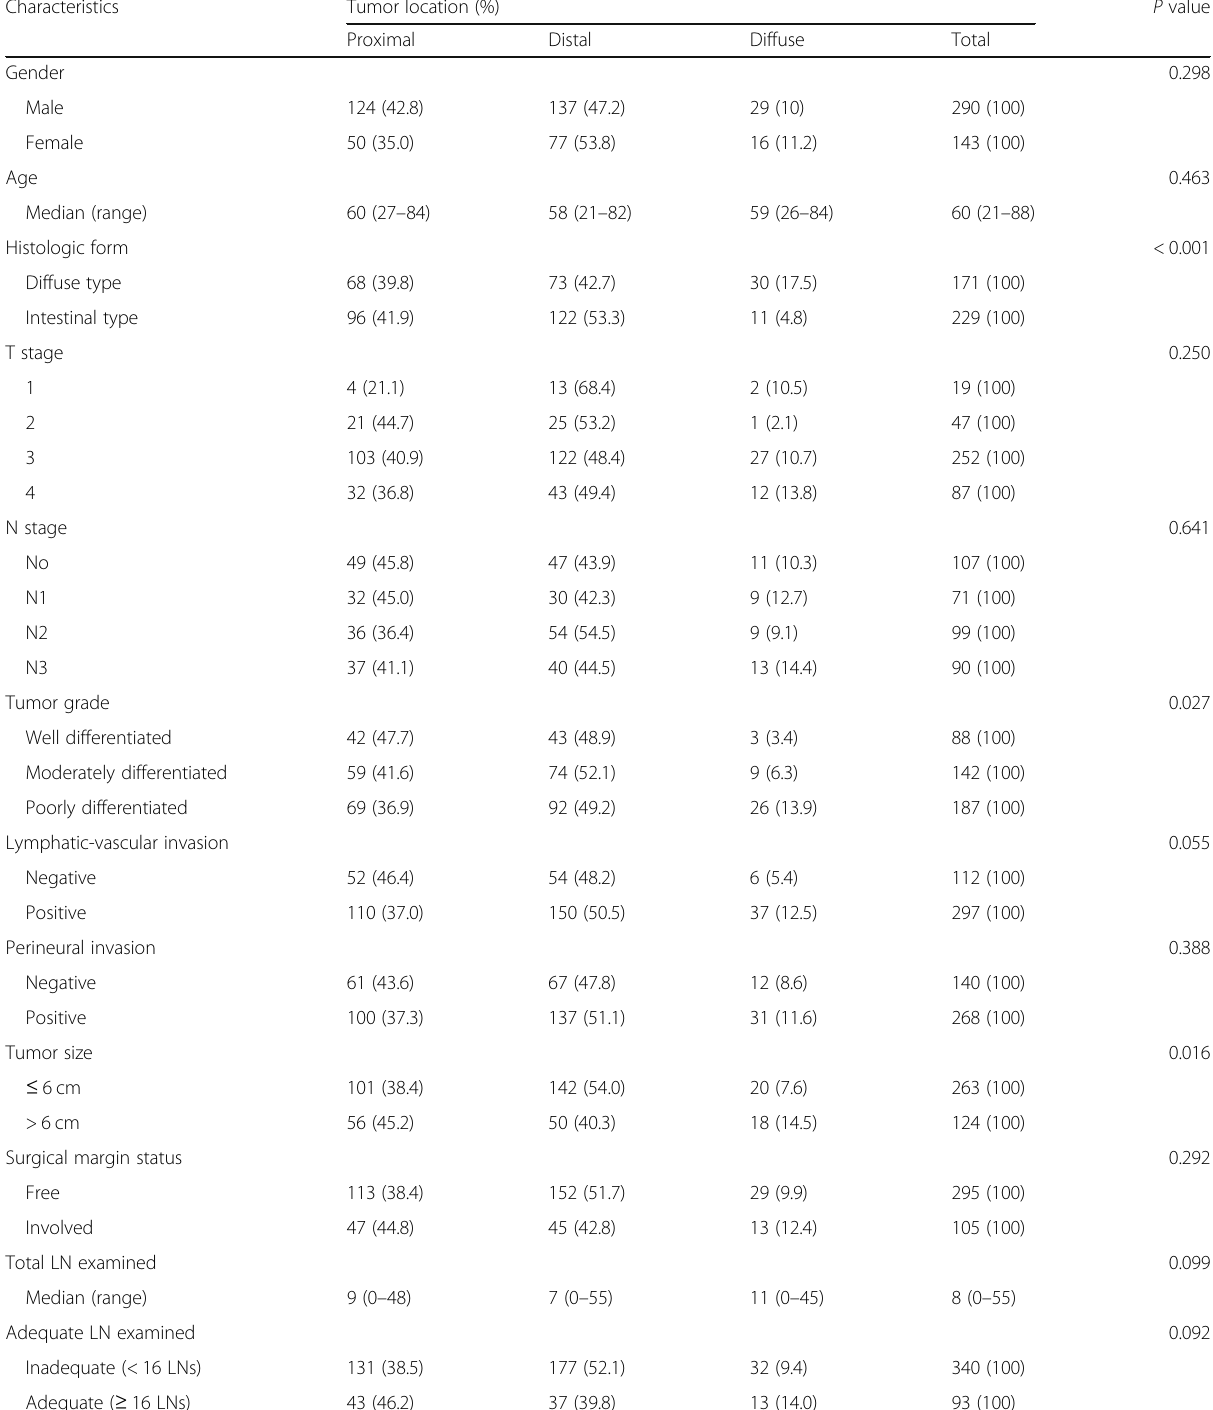
Table 1 Patient and tumor characteristics by tumor location